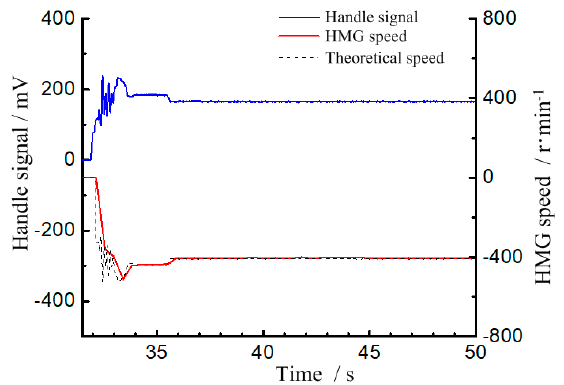
Figure 12. Curves of HMG speeds and handle signal.